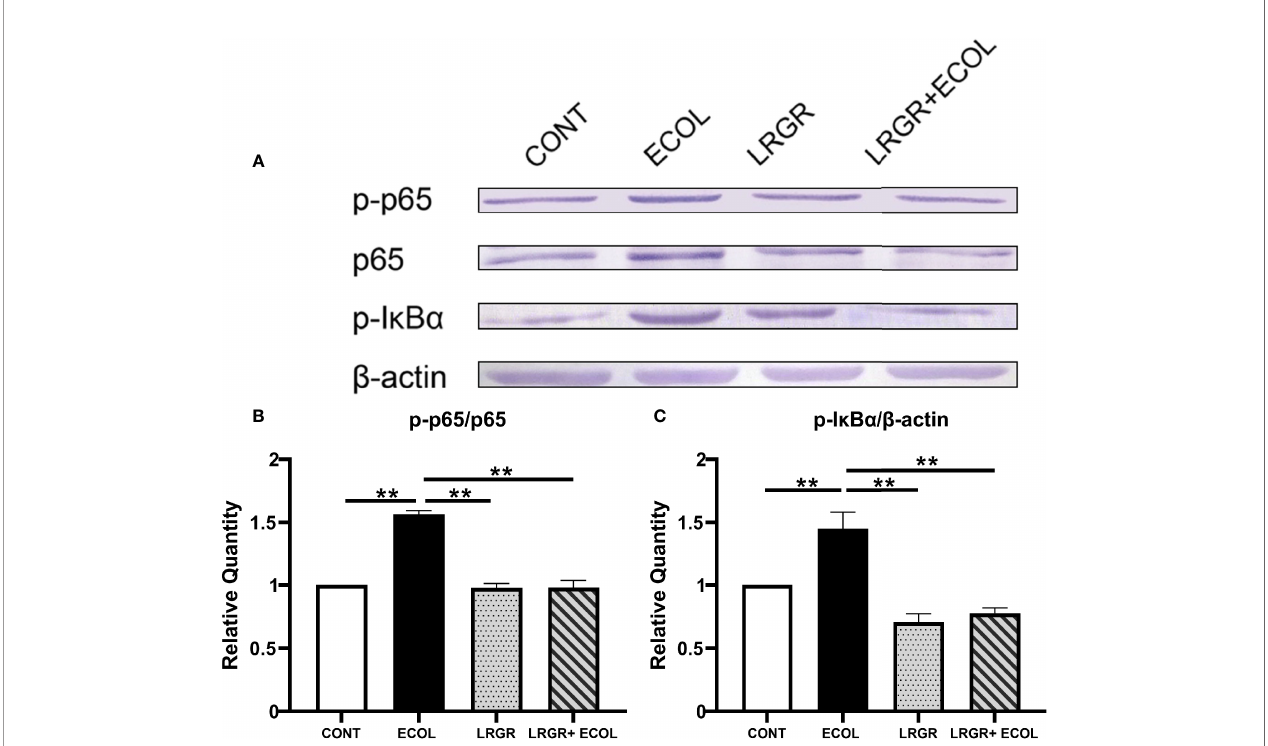
FIGURE 4 | L. rhamnosus GR-1 affects the NF- k B pathway protein expression in E . coli -induced BEECs. The p-p65 and p-I k B a expressions in the L. rhamnosus GR-1- and E . coli -elicited BEECs were explored by Western blotting. (A) p-p65, p-I k B a . The resultant phosphorylated protein as percentages of total protein is averaged and plotted, (B) p-p65/p65 and (C) p-I k B a / b -actin. Data represented are means ± SEMs from triplicate experiments. ** P < 0.01.